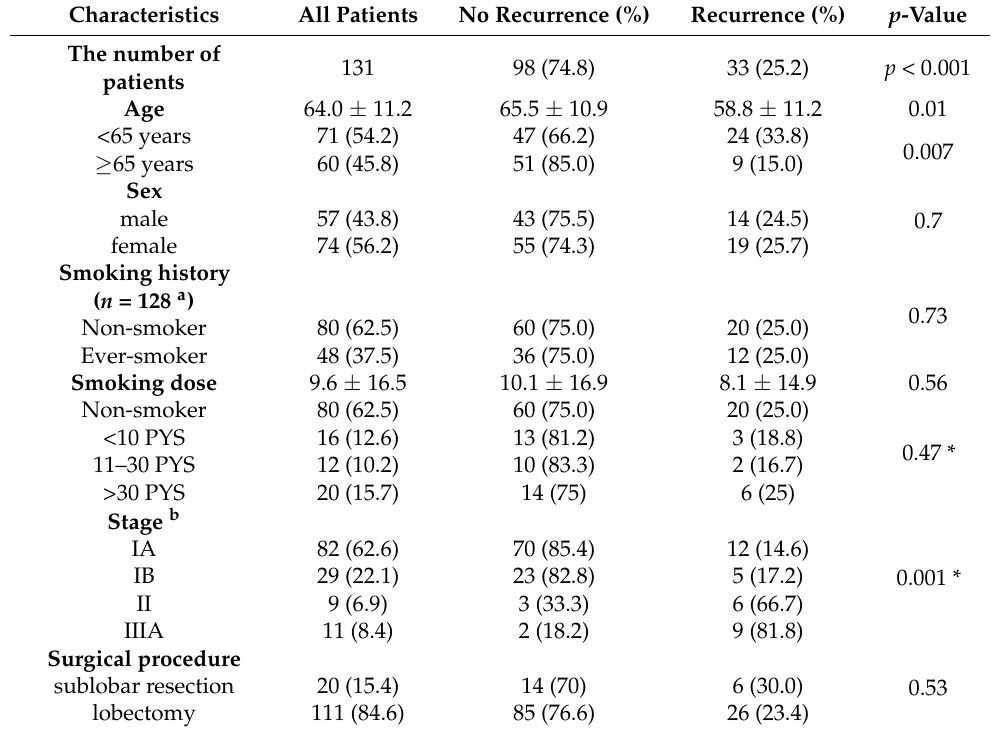
Table 1. Comparison of the clinic-pathological characteristics of 131 patients with EGFR-mutated lung adenocarcinoma according to